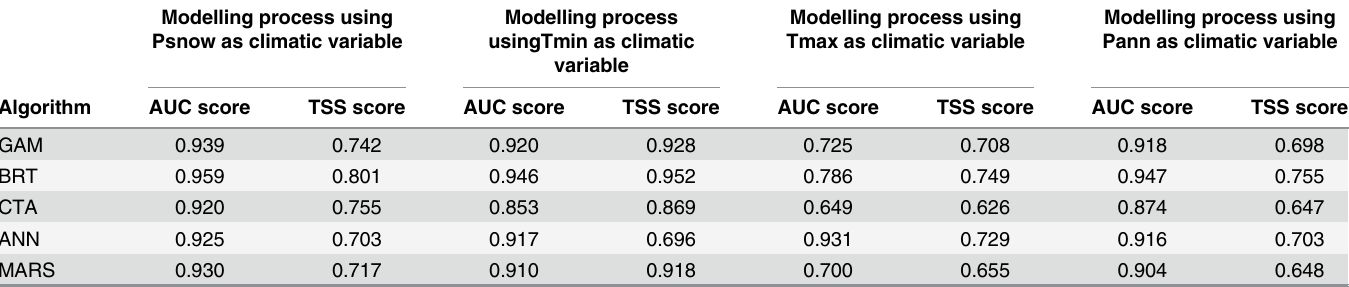
Table 1. Models AUC and TSS performance scores. Differences in the AUC and TSS performance scores in the five algorithms used to model the current distribution of R . ferrugineum in Andorra. Modelling process using Psnow as climatic